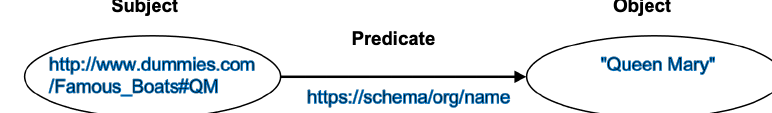
Figure 3. An RDF triple (N-Triples notation), referring to a Web resource about the Queen Mary boat, and its graphical representation.